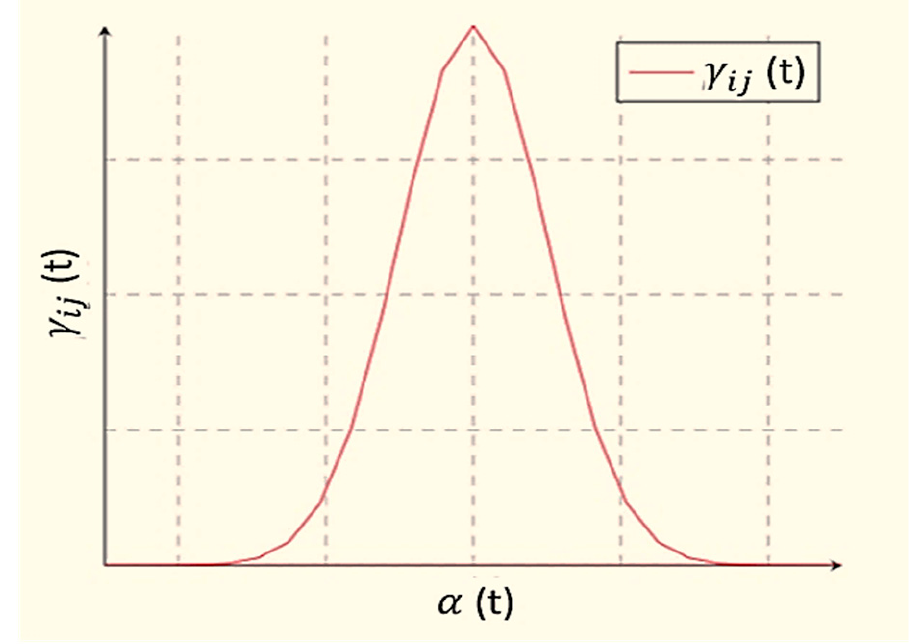
Figure 6. Relation between the learning rate and radius.